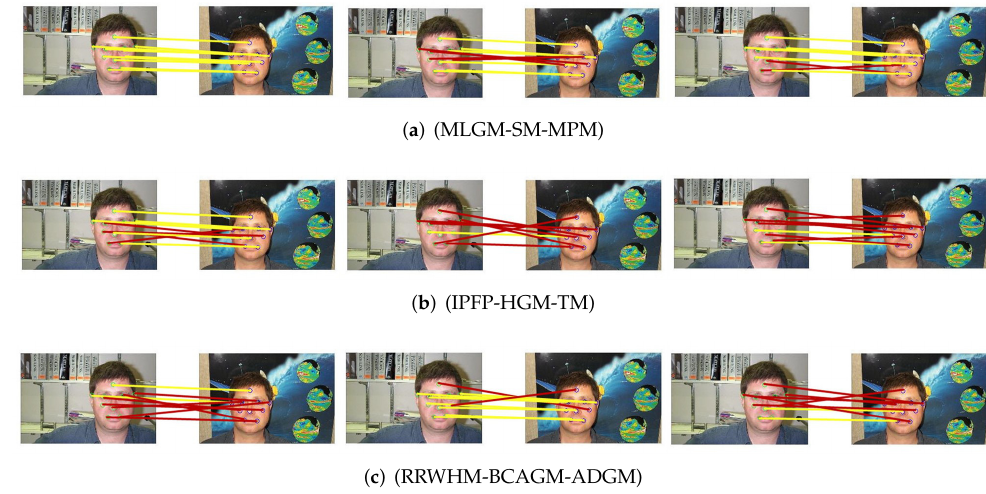
Figure 10. Example results of experiments on the Face dataset, in which red and yellow lines denote correct and incorrect matching results.